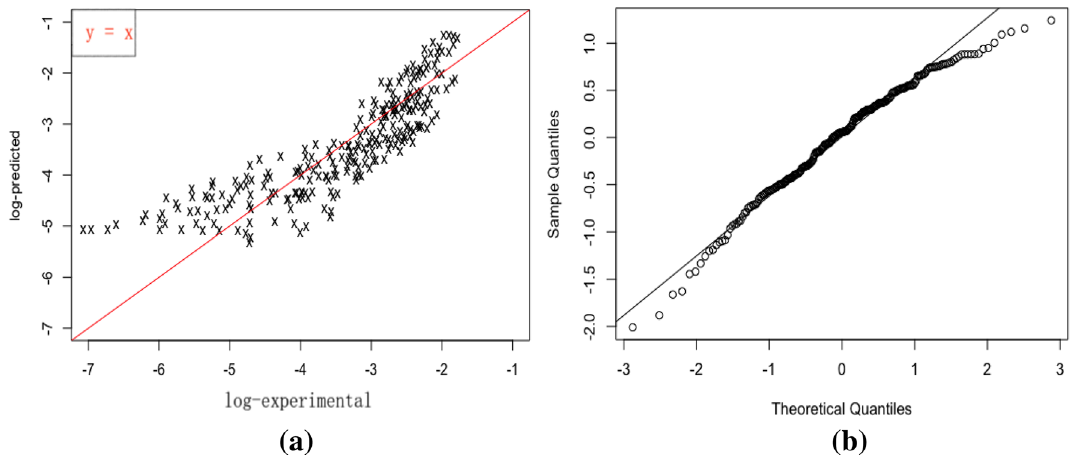
Figure 2. Multiple linear model validation: samples from Yan’an; ( a ) Predicted vs experiment (log), ( b ) QQ-plot for residual checks.